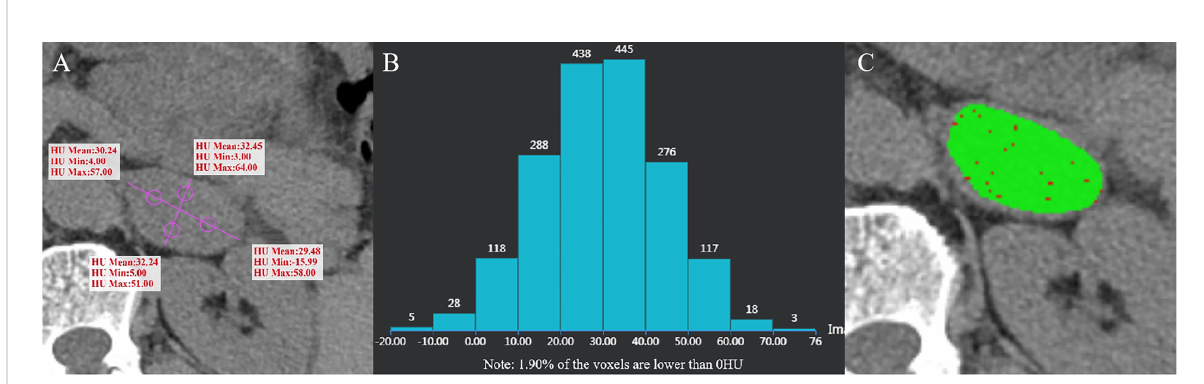
FIGURE 4 Ganglioneuroma of the left adrenal gland in a 55-year-old man. AV mean = 31.103 HU, AV min = -0.75 HU (A) , and CTH negative pixel =1.9% (B) . The CT value in the red area is ≤ 10 HU, and the CT value in the green area is > 10 HU (C)